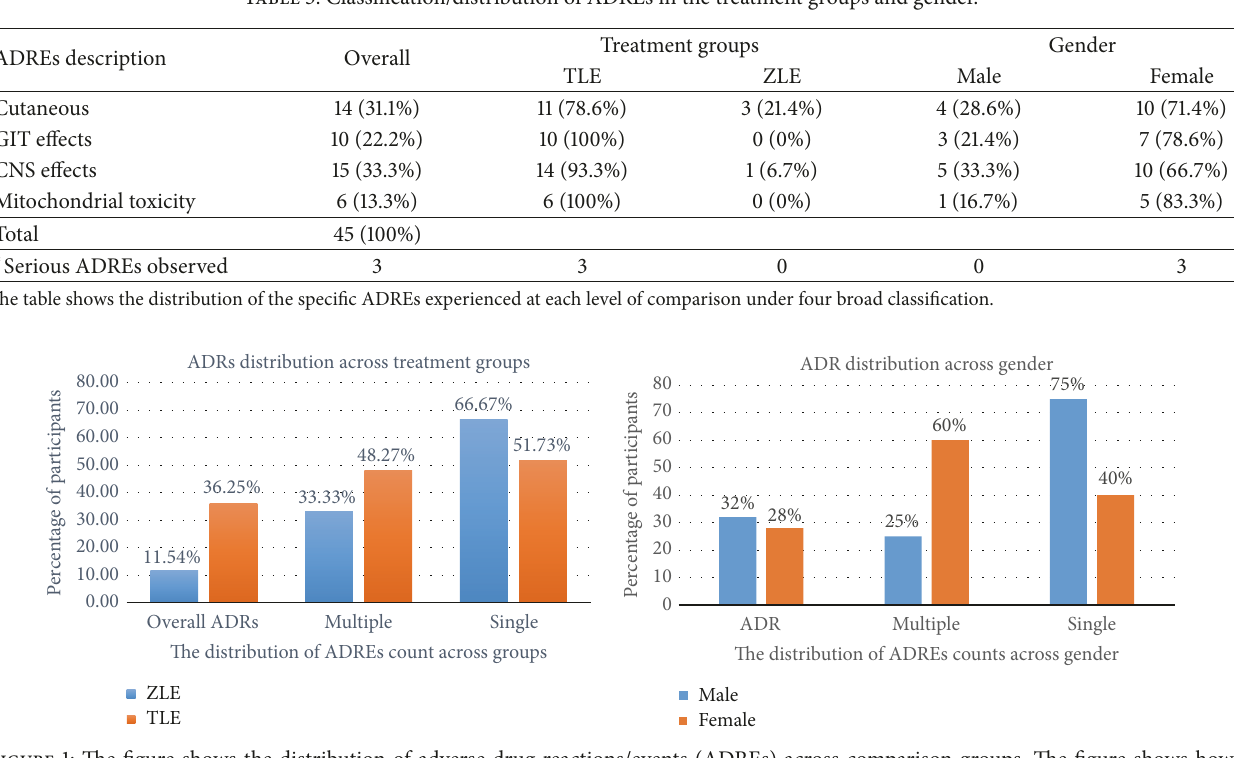
Figure 1: The figure shows the distribution of adverse drug reactions/events (ADREs) across comparison groups. The figure shows how treatment type and gender affect the occurrence of adverse drug reactions/events (ADREs) among participants. ADR refers to the proportion of participants who experienced adverse drug reactions/events in each comparison group. Single: the proportion of persons who had only one ADRE out of the number of persons with ADREs in each group. Multiple: the proportion of persons who had two or more ADREs out of the number of persons with ADREs in each